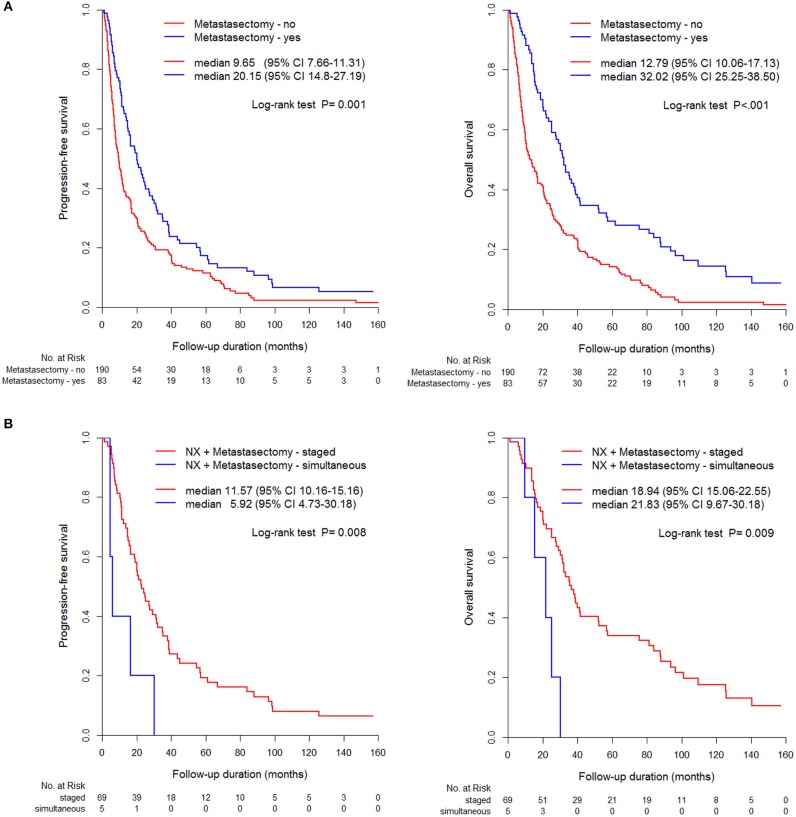
Comparison of PFS and OS between metastasectomy and non-metastasectomy (A) without/ (B) with nephrectomy.